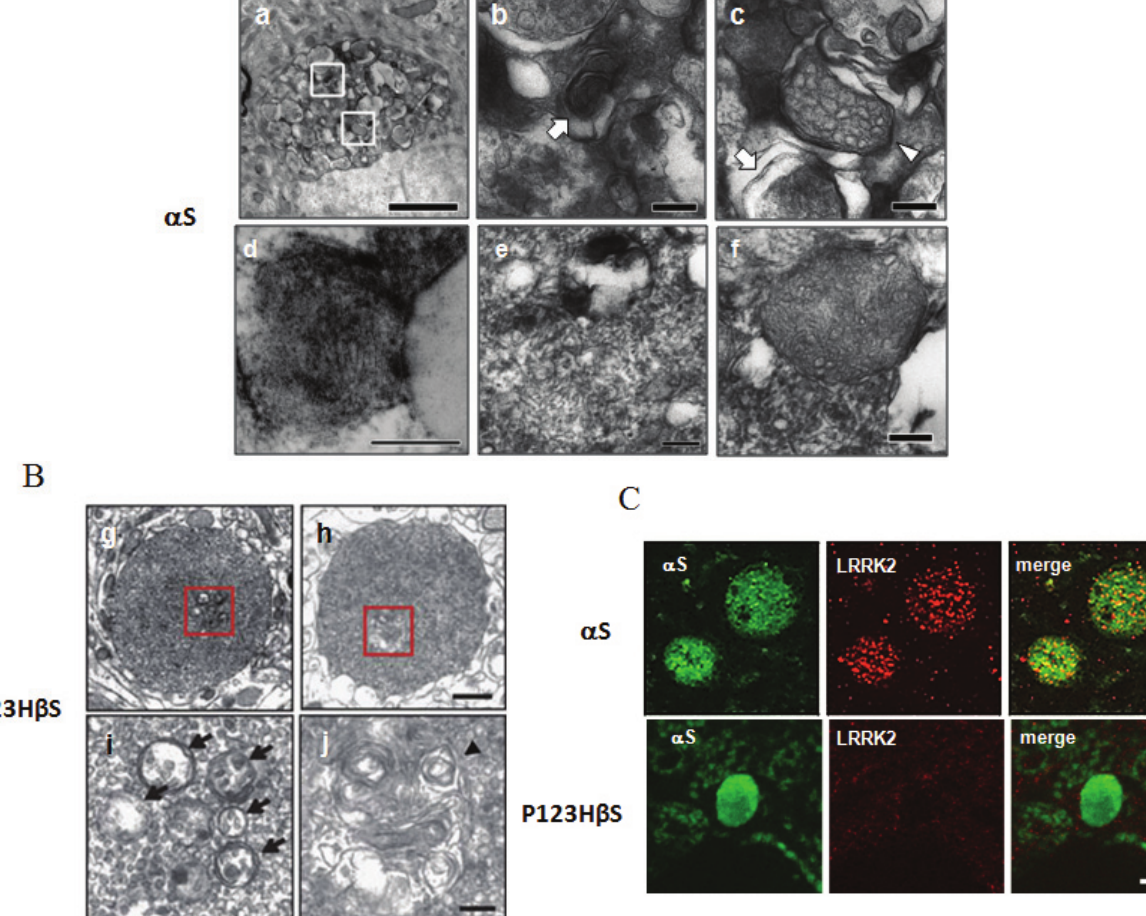
Figure 2. Histological analyses of the globules formed in the brains of both (cid:2)S- and P123H (cid:3)S tg mice. ( A ) Immunoelectron microscopy: The (cid:2)S-globules ( a ) were characterized by lysosomal pathologies such as an (cid:2)S-immunopositive multivesicular body ( b : arrow) and autophagic vacuoles ( c ). ( b ) and ( c ) are magnifications from ( a ). Formation of curvilinear bodies ( d ) and a fingerprint profile ( e ) adjacent to a lipid droplet ( L ) are reminiscent of lysosome storage disease. Some mitochondria were swollen and deformed ( f ); ( B ) Immunoelectron microscopy: Abnormal lysosomal pathologies were also observed in the P123H (cid:3)S-globules. ( i ) and ( j ) are magnifications from ( g ) and ( h ), respectively; ( C ) Immunofluorescence: Immunoreactivities of LRRK2 were detected in the (cid:2)S-globules (upper 3 panels) but not in the P123H (cid:3)S-globules (lower 3 panels). Reprinted from Mol. Brain, Sekigawa et al. , 5:34 with permission